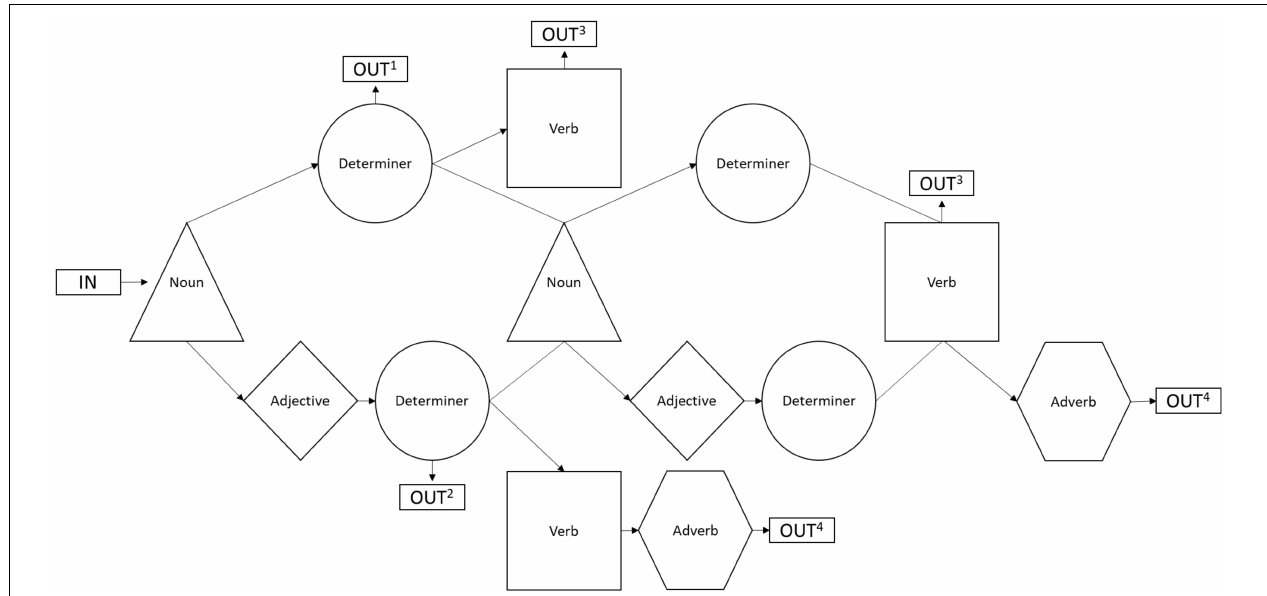
FIGURE 2 | Chart depicting the possible word class combinations of items generated by the Brocanto2 grammar. The superscript at each output classifies the category of phrase or sentence that such a sequence produces; 1 denotes a simple phrase (noun + determiner), 2 denotes a complex phrase (noun + adjective + determiner), 3 denotes a simple sentence (noun + determiner + verb; noun + determiner + noun + determiner + verb), and 4 denotes a complex sentence (noun + adjective + determiner + verb + adverb; noun + adjective + determiner + noun + adjective + determiner + verb +